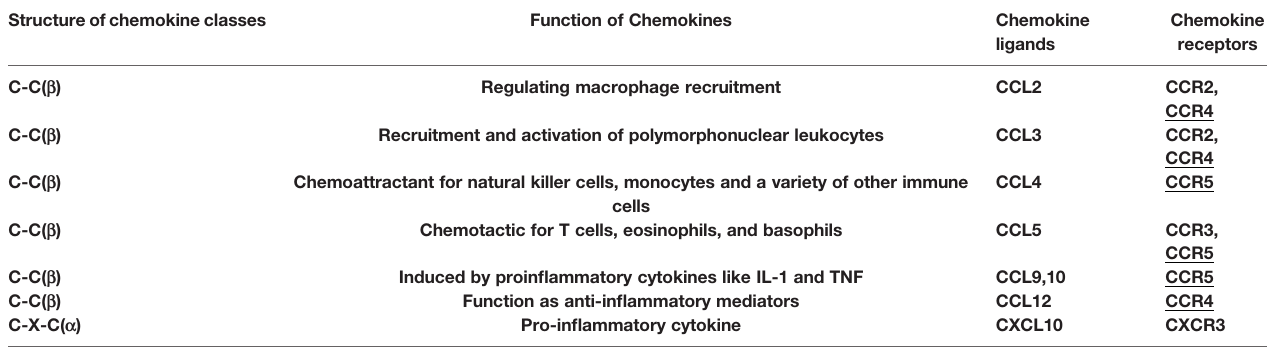
TABLE 1 | Information about the type and functions of expressed chemokines in BV2 cells. Structureofchemokine classes